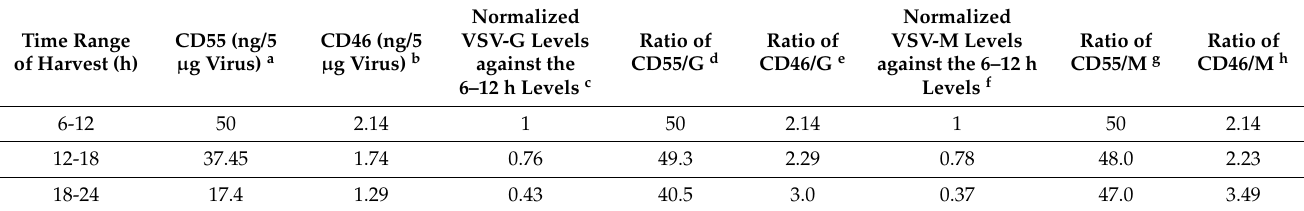
Figure 5. Complement regulator CD55 is found in greater abundance than CD46 on VSV from HeLa cells. ( A ) Equal concentrations of protein in the purified virus (5 µ g) were separated by SDS-PAGE and subjected to Western blotting. The proteins that have been probed are indicated in the right, and their corresponding molecular weights are in parentheses. ( B ) An ELISA specific to VSV was performed by coating wells with serially-diluted gradient-purified VSV. The adsorbed virus particles were detected using an anti-VSV-G antibody. Variability in the absorbance was observed even at similar concentration of viruses purified at varying time intervals. Across the samples, an absorbance of ~1.3 was found to be common; this is indicated by the lines drawn against the optical density. ( y -axis) to the corresponding concentrations ( x -axis). Table 2. Levels of CD55 and CD46 associated with sucrose gradient-purified VSV from HeLa cells at various time intervals. a,b The concentration of the virion-associated CD55/CD46 was calculated from the pixel intensity of the known concentrations of rCD46 and rCD55 run in parallel (Figure 5A). The concentration of CD55 and CD46 is depicted as ng/5 µ g of VSV. c,f Based on the densitometric analysis of VSV-G or M, further normalization was performed relative to the values obtained at 6–12 h (taken as 1). The values indicate the decline in the concentration of G or M relative to 6–12 h. d,g The ratio of CD55 to VSV-G or VSV-M was calculated by dividing the CD55 concentration at a specific time point by the normalized levels of G or M. The values in d were obtained by dividing a by c , and those in e by dividing b by c . Similarly, the ratios in g and h were obtained by dividing a by f and b by f ,